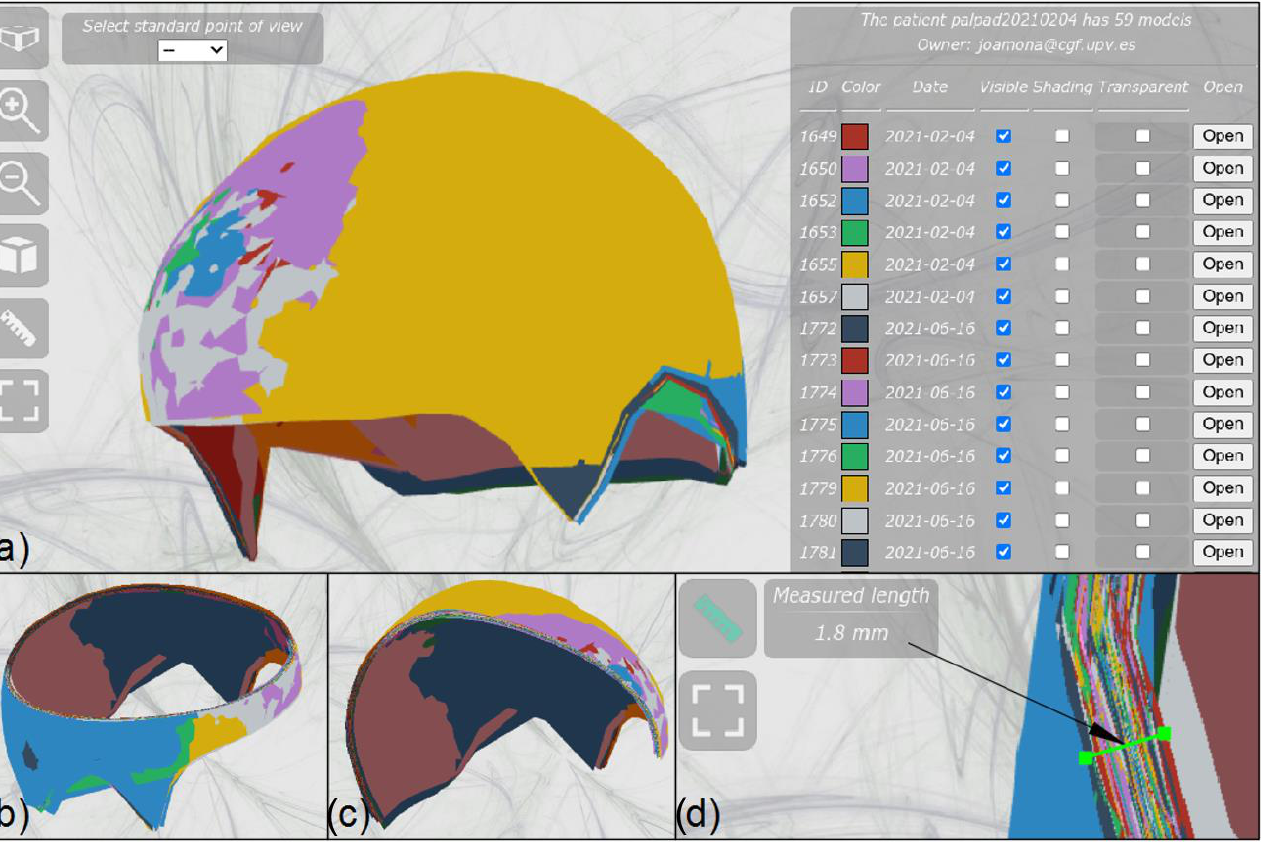
Table 1. Anthropometric parameters and cranial deformation indices.